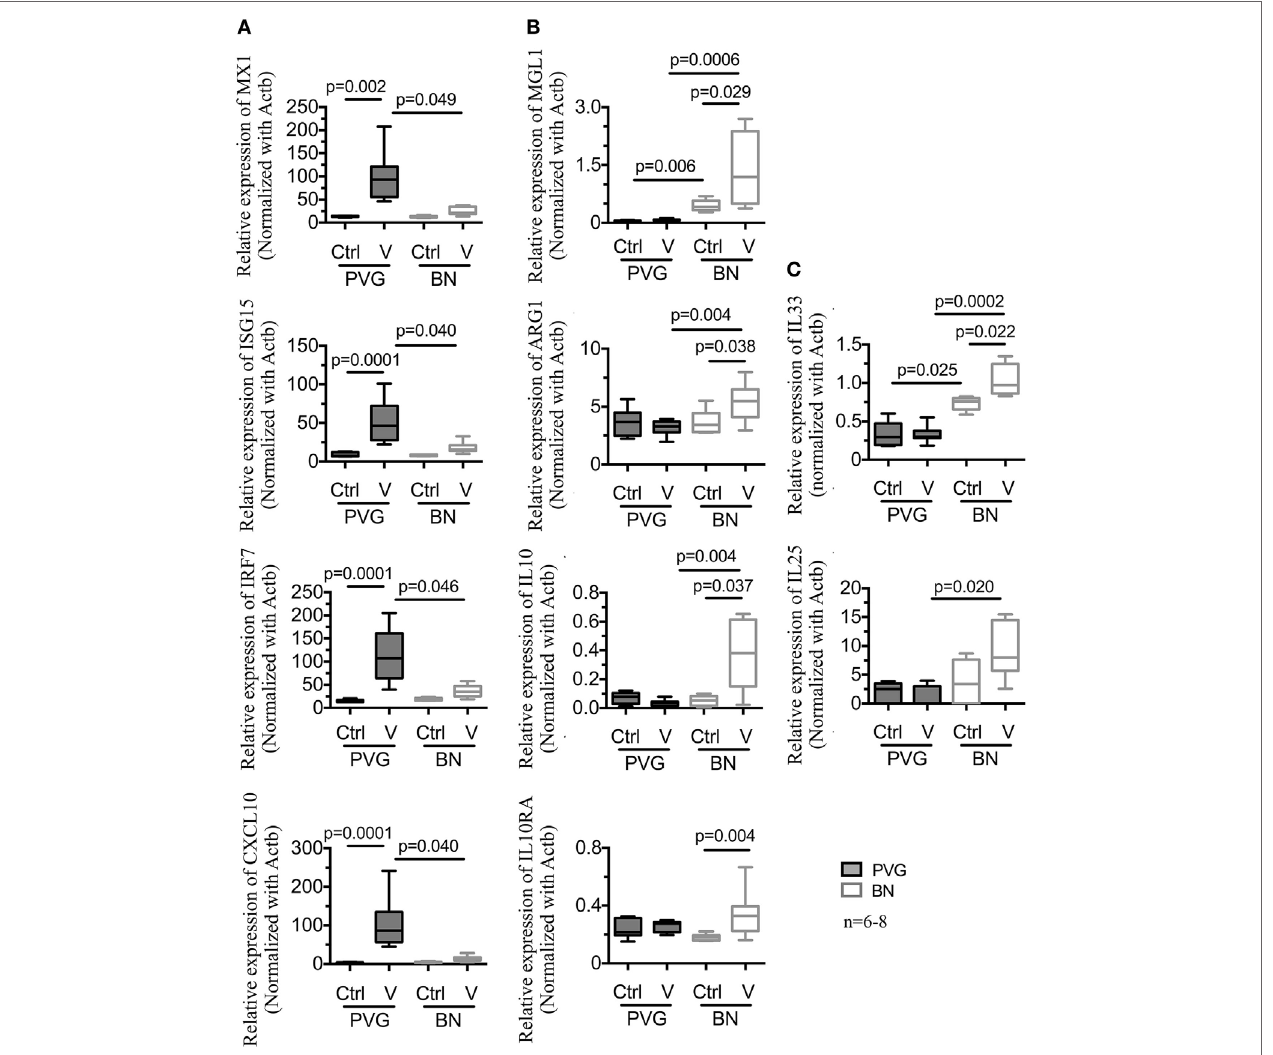
FigUre 3 | vMC 0 infection in BN is characterized by an alternative activation of macrophages and Th2 response contrary to an archetypal type I interferon response. Total RNA was obtained from independent bronchoalveolar lavage samples of PVG ( ◾ ) and BN ( ◽ ) rats at day 1 post-infection. Real-time quantitative PCR was carried out on a subset of genes representative of the main pathways identified in Figure 2 . (a) Viral infection induced the expression of type I interferon and antiviral response genes in PVG, whereas in BN, we observed an increased expression of (B) alternative activation of macrophages and immunoregulatory genes, and (c) Th2 response genes. n = 6–8; statistical analysis was carried out by non-parametric Kruskal–Wallis test followed by Dunn’s multiple comparisons (overall p -values, MX1: 0.0001; ISG15: 0.0001; IRF7: 0.0001; CXCL10: 0.0001; MGL1: 0.0001; ARG1: 0.0265; IL10: 0.028; IL10RA: 0.0328; IL33: 0.0002; and IL25: